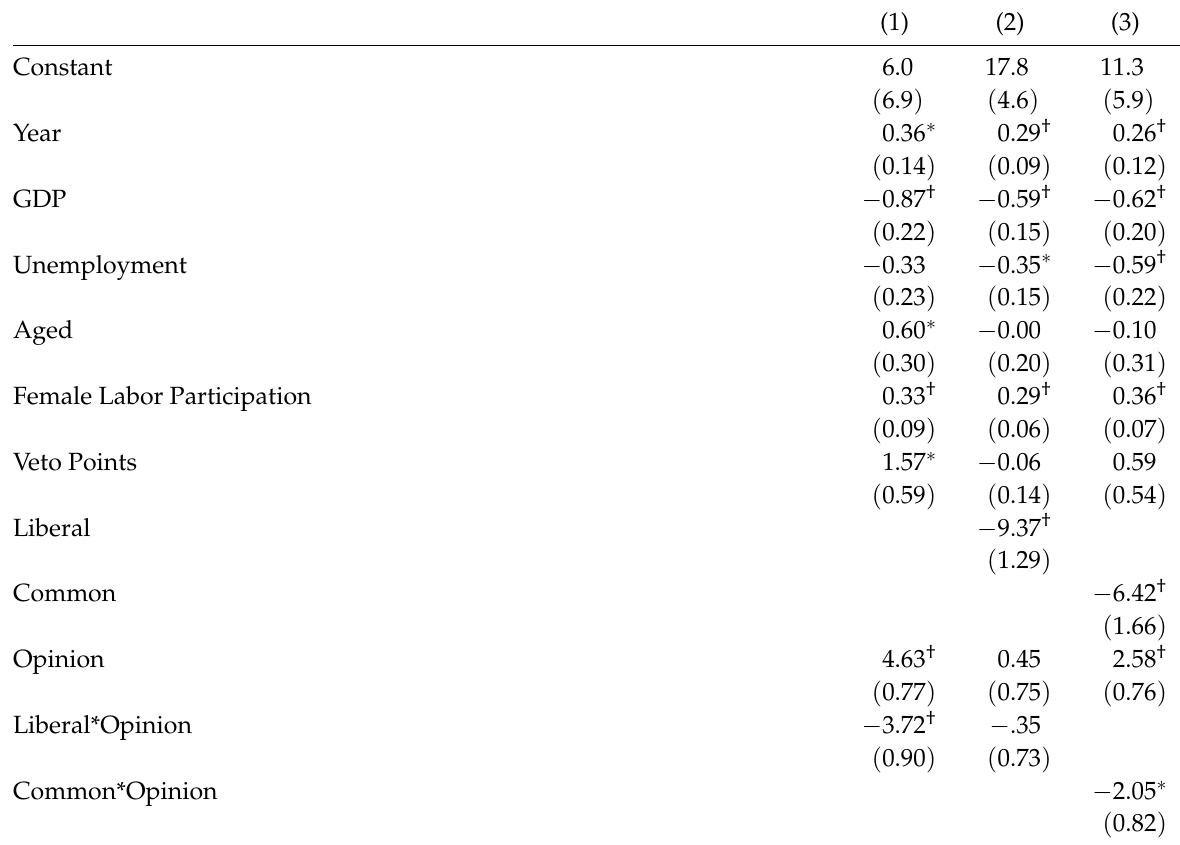
Table 1: Estimated Effects of Public Opinion on Welfare